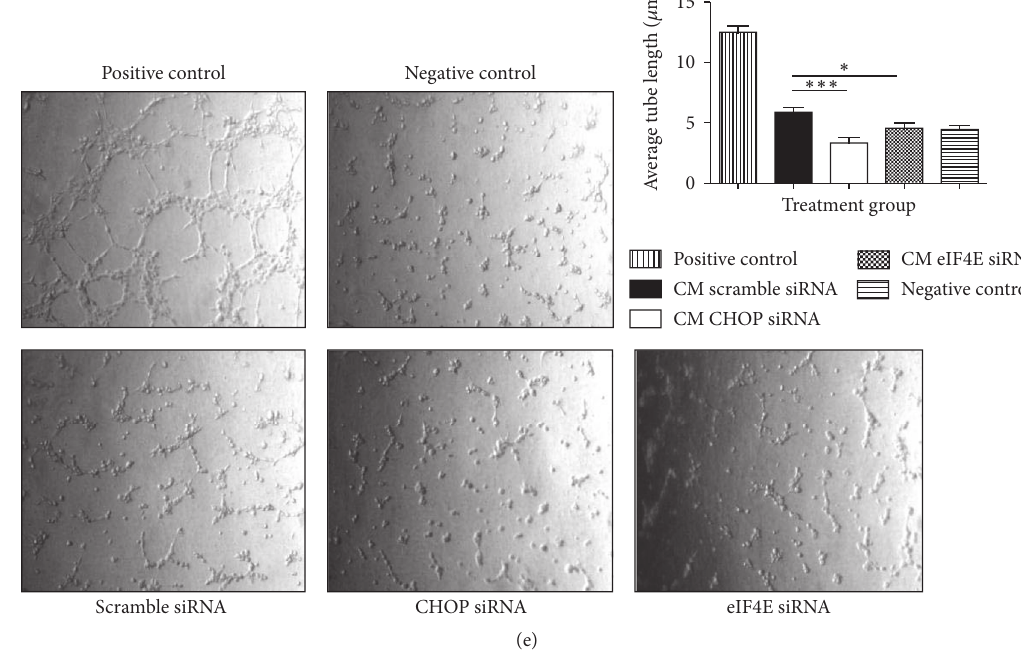
Figure 2: FUS-CHOP and eIF4E are critical for myxoid liposarcoma survival and promote the angiogenic properties of myxoid liposarcoma. MLS 1765 cells were treated with CHOP-directed (a), eIF4E-directed (b), or scramble siRNA and the percentage of protein reduction was determined by densitometry. MLS 402 and MLS 1765 cells were treated with CHOP-directed, eIF4E-directed, or scramble siRNA for 5 days and cell viability determined by MTS uptake (c). Three independent experiments were performed, and the data are presented as the mean + SEM. MLS 1765 cells treated with CHOP-directed, eIF4E-directed, or scramble siRNA for 5 days, and then RT-qPCR was performed to quantify the expression of VEGF ligands and receptors. Data are presented relative to the housekeeping gene GAPDH; three independent experiments were performed; and the data are presented as the mean + SEM (d). HUVECs were suspended in Matrigel, and then conditioned medium from MLS 402 cells pretreated with CHOP-directed, eIF4E-directed, or scramble siRNA was applied to the HUVECs. Images were acquiredathourlyintervals,andthefiguredisplaysrepresentativeimagestakenat8 h(left).TubelengthsweremeasuredusingImageJ(version 1.47d). Three independent experiments were performed, and the data are presented as the mean + SEM (e). CM, conditioned